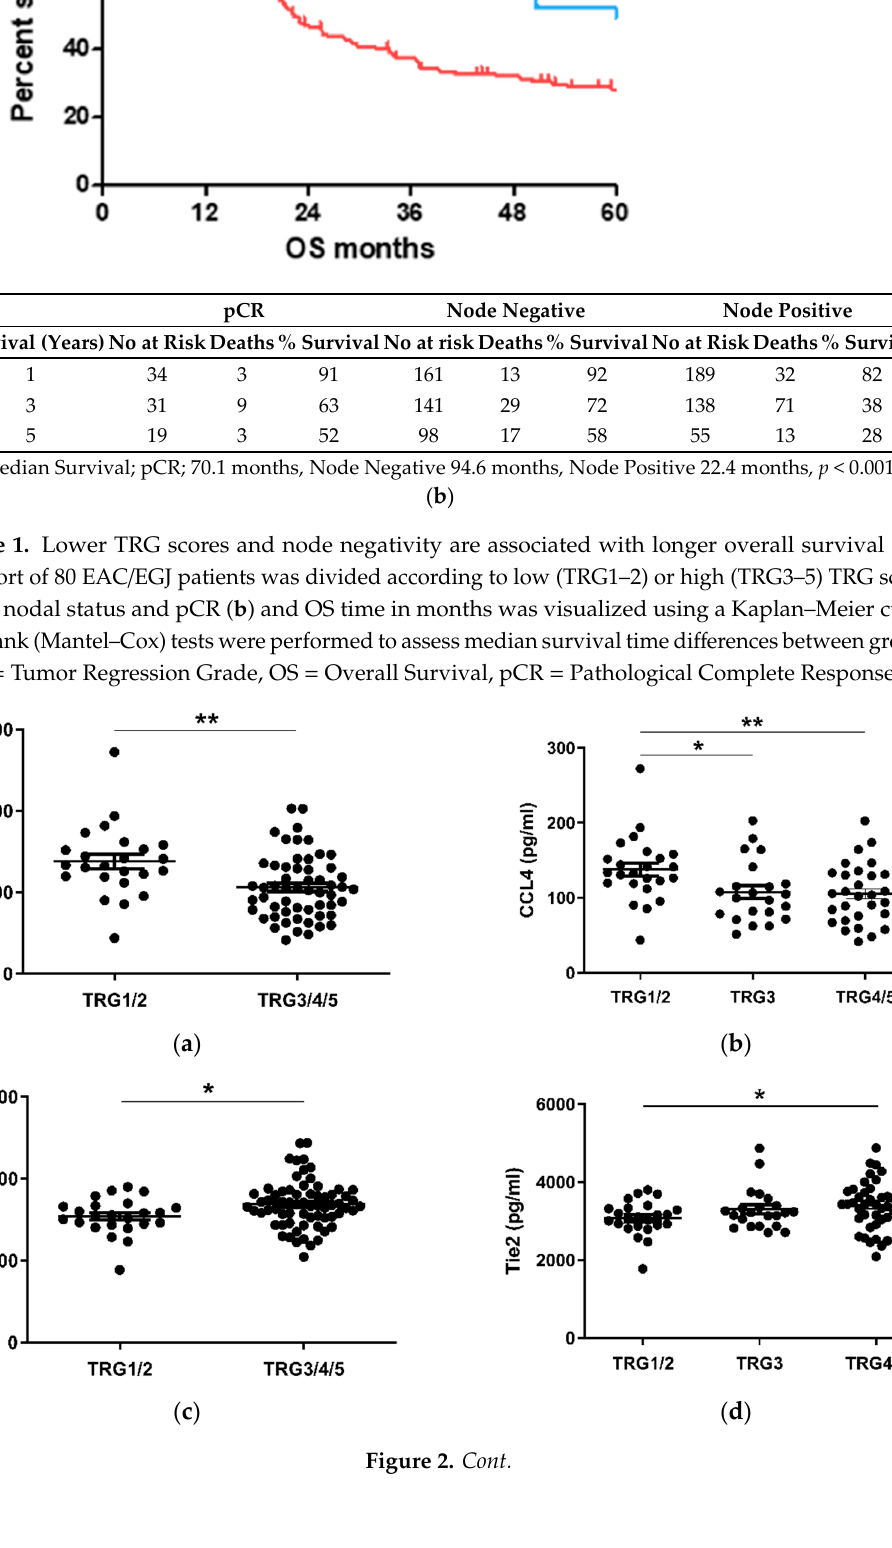
Figure 1. Lower TRG scores and node negativity are associated with longer overall survival time. A cohort of 80 EAC/EGJ patients was divided according to low (TRG1–2) or high (TRG3–5) TRG scores ( a ),